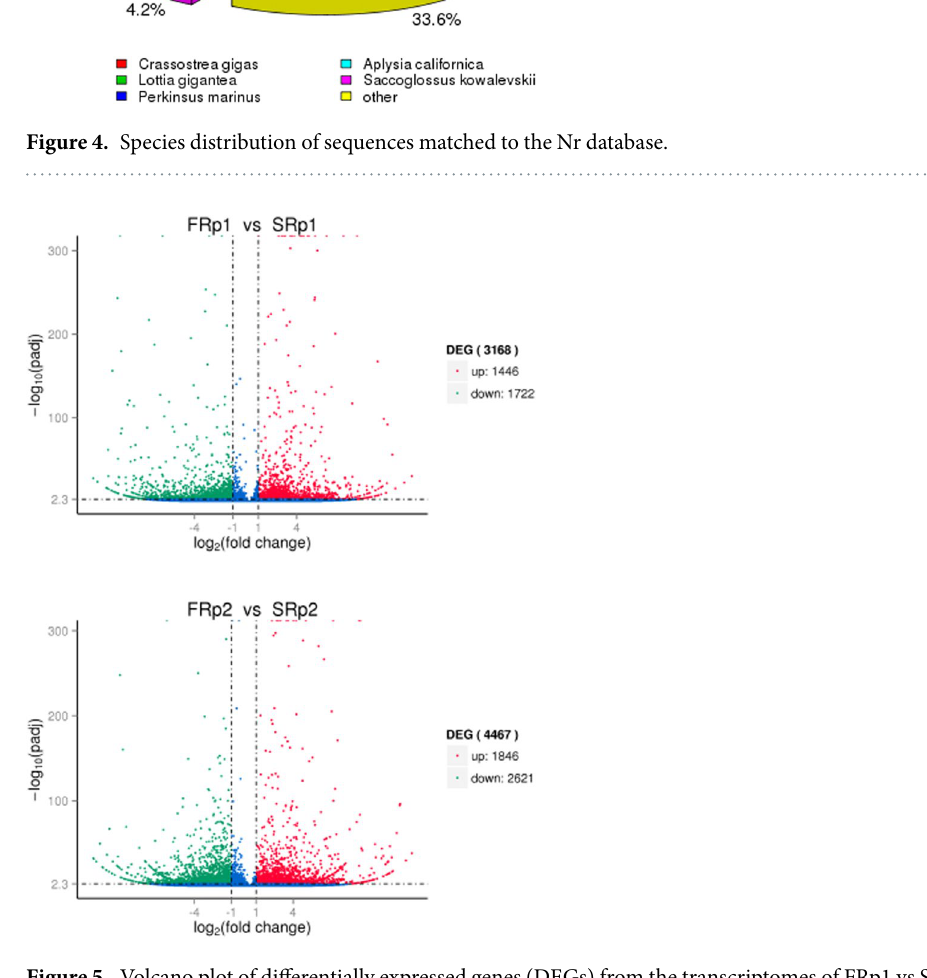
Figure 5. Volcano plot of differentially expressed genes (DEGs) from the transcriptomes of FRp1 vs SRp1 and FRp2 vs SRp2 in R. philippinarum